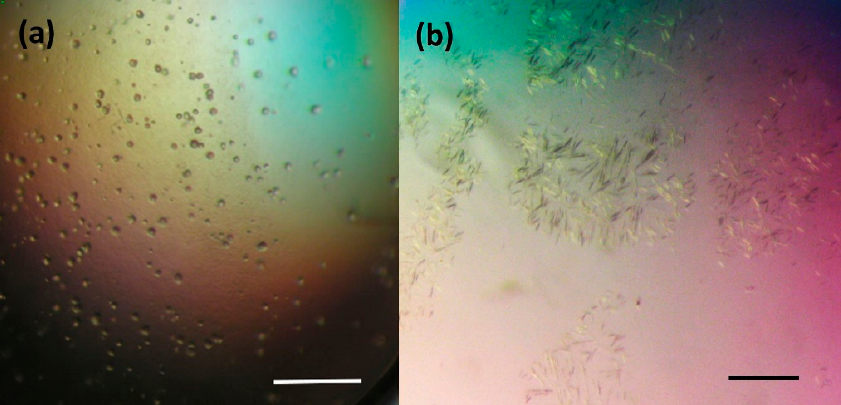
Figure 1. Results of initial crystallization experiments of DbeA Δ Cl protein from B. elkanii USDA94: (a) microcrystals and (b) small 2D needle crystals. The scale bar represents 100 µm.